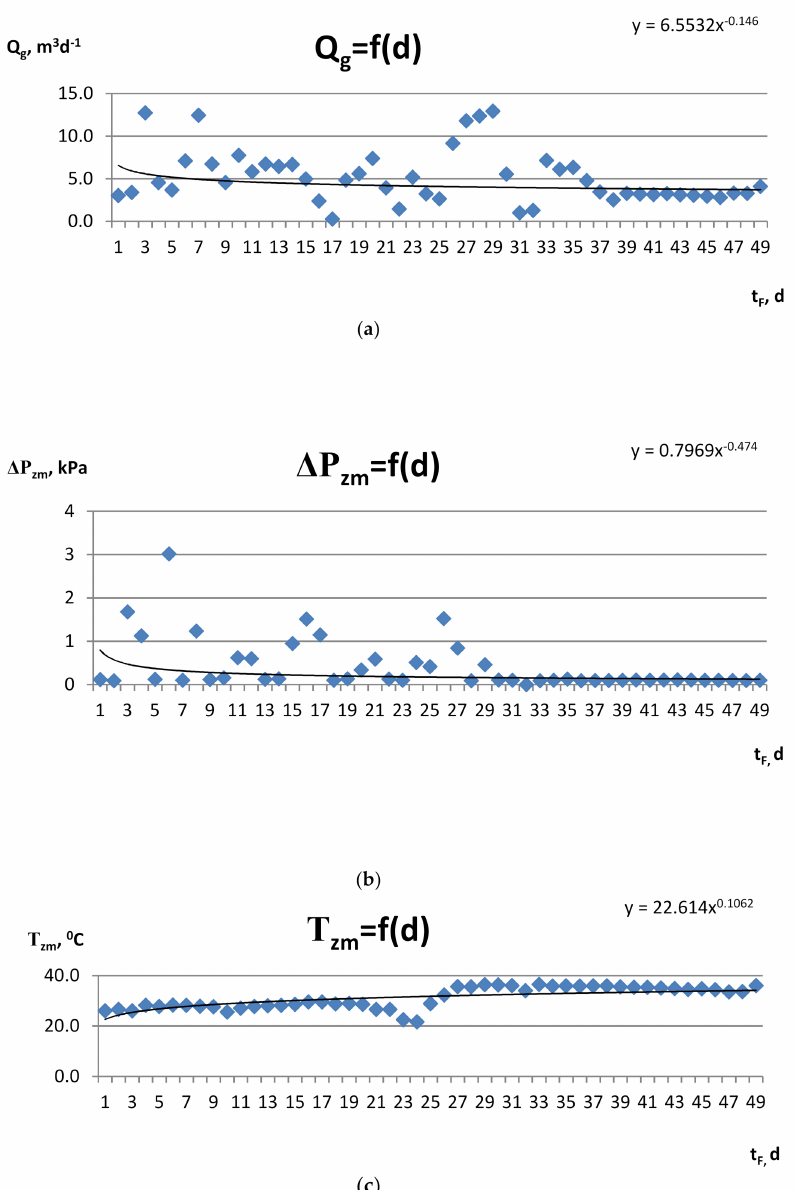
Figure 10. Changes in the parameters of the mesophilic fermentation technology from a polydisperse substrate for the average daily production of agricultural biogas [own study]: ( a ) time dependence of the gas stream; ( b ) time dependence of pressure; ( c ) time dependence of